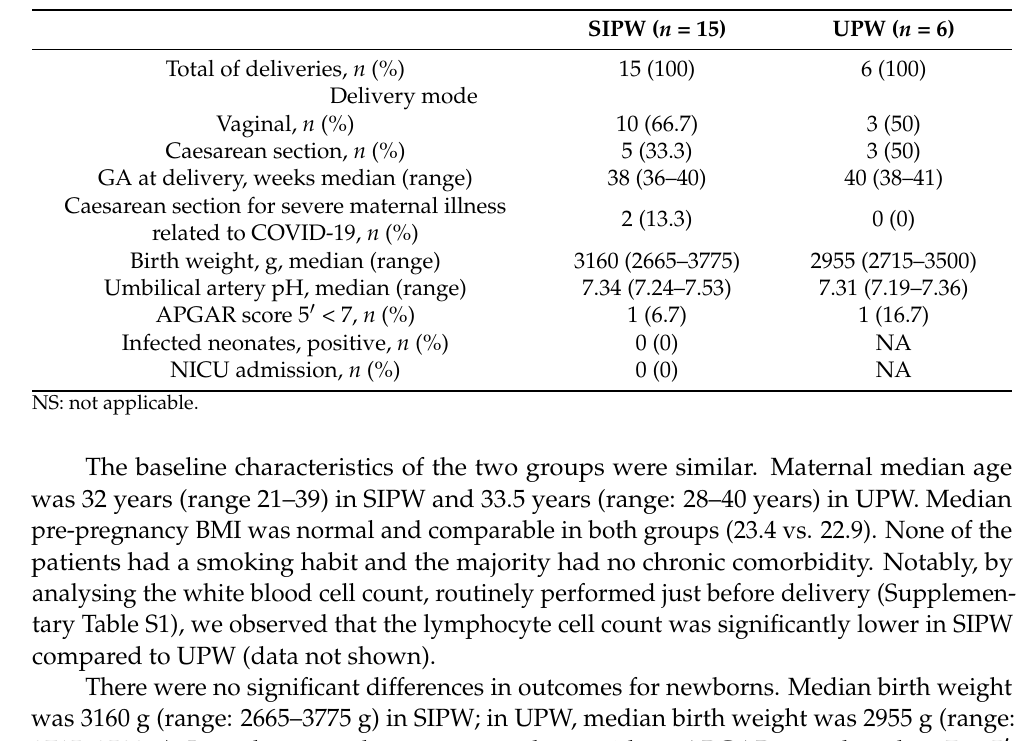
Table 2. Maternal and pregnancy outcomes in the study